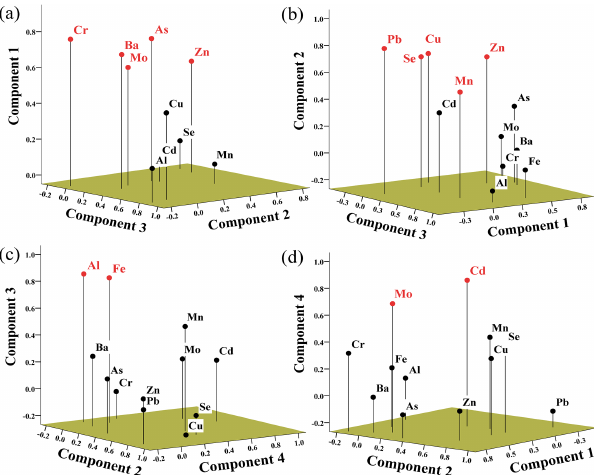
Figure 4. Loadings of (a) Component 1, (b) Component 2, (c) Com- ponent 3 and (d) Component 4 for trace elements in total fraction in PM 2 . 5 .